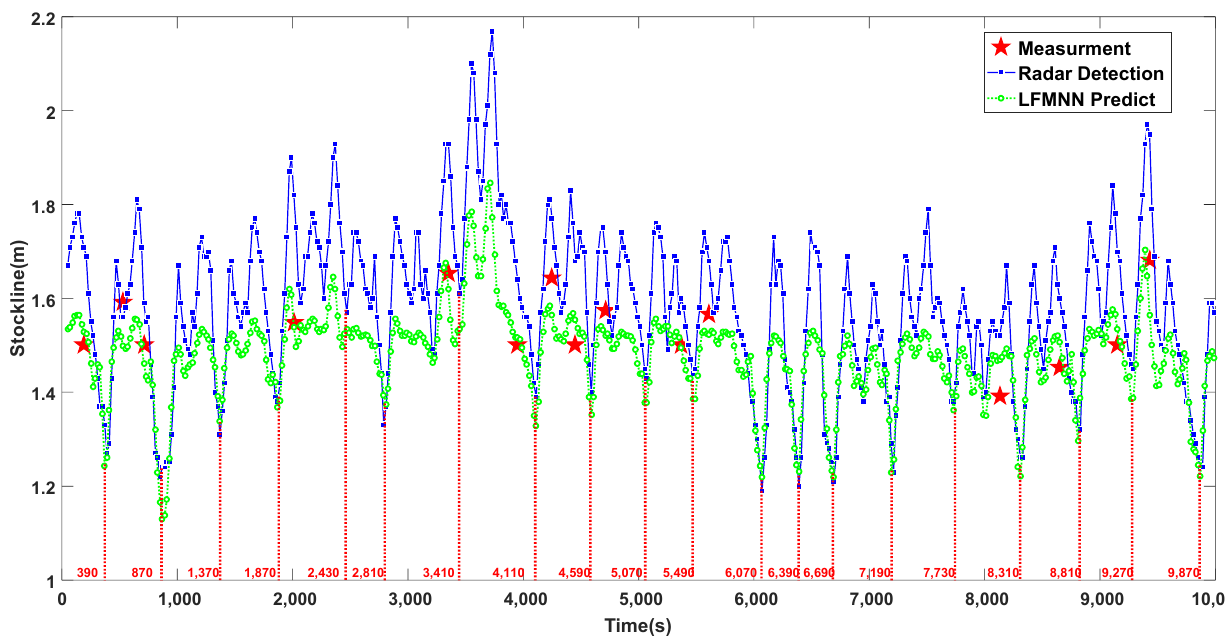
Figure 7. Trend of burden level prediction under normal working conditions.